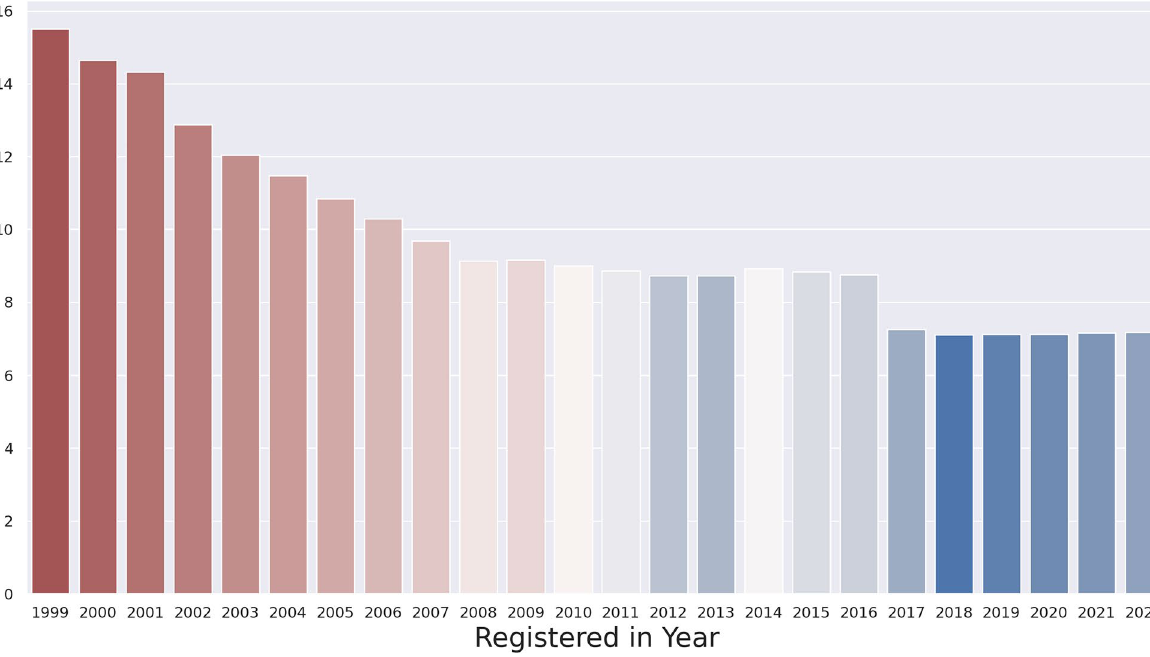
Figure 2. Average missing value rates (proportion of sum of missing values over total number of studies) per year from 1999 to 2022 considering the 24 study characteristics features used in this